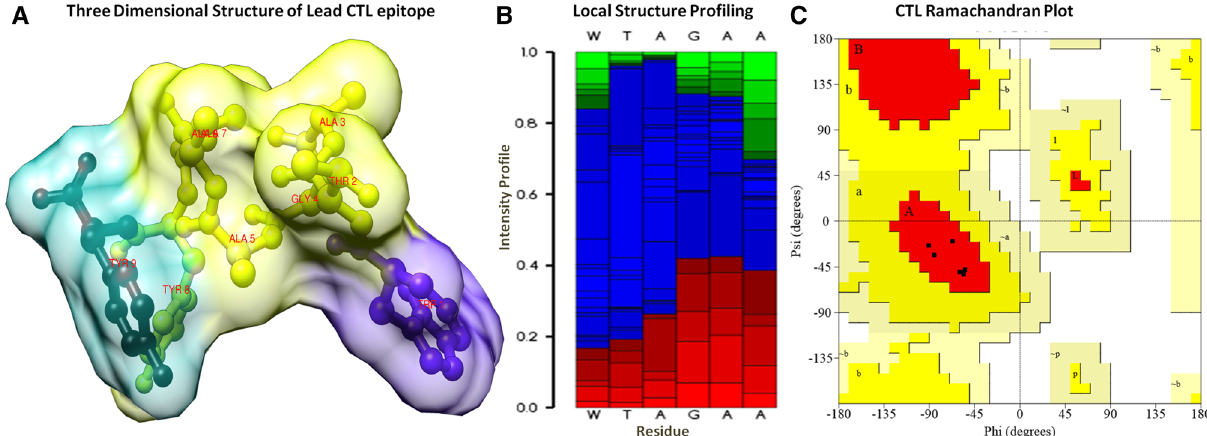
Figure 7. ( A ) The three-dimensional globular structure of CTL epitope (Vaccine candidate). ( B ) Local secondary structure analysis of CTL epitope, Structural profile is shown by helicity (red), extended coils (green) and coils (blue). ( C ) Ramachandran plot analysis of vaccine candidate, depiction residues were lying in a favorable